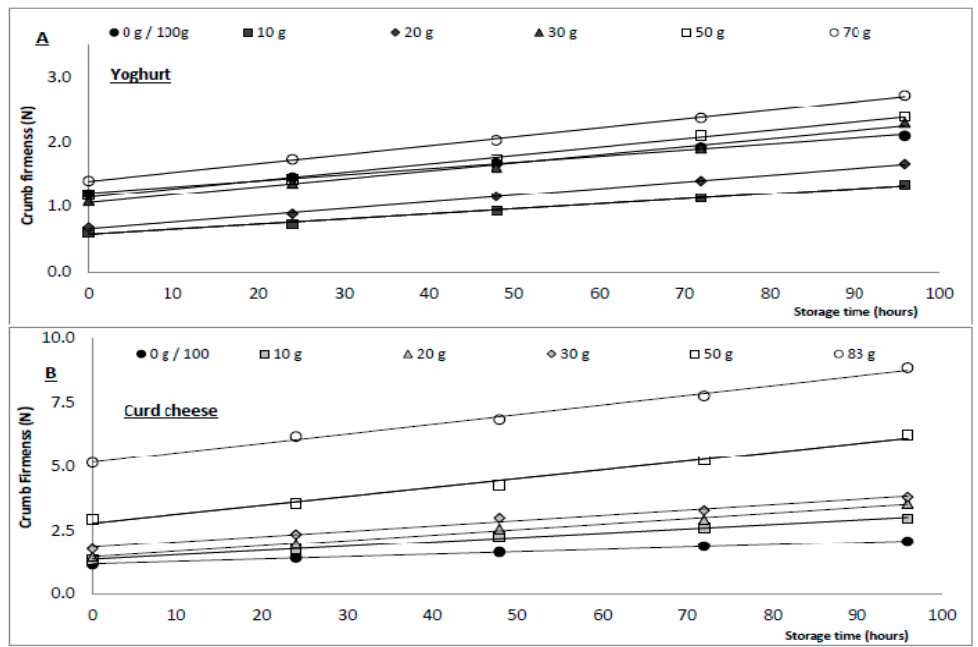
Figure 3. Variation of firmness (N) and aging kinetics for breads prepared with di ff erent contents of Yg ( A ) and Cc ( B ) addition, replacing the flour in bread formulation, at initial and 96 h of storage time, and respective linear equations: staling rate as crumb firmness with time for the di ff erent concentrations of Yg and Cc.